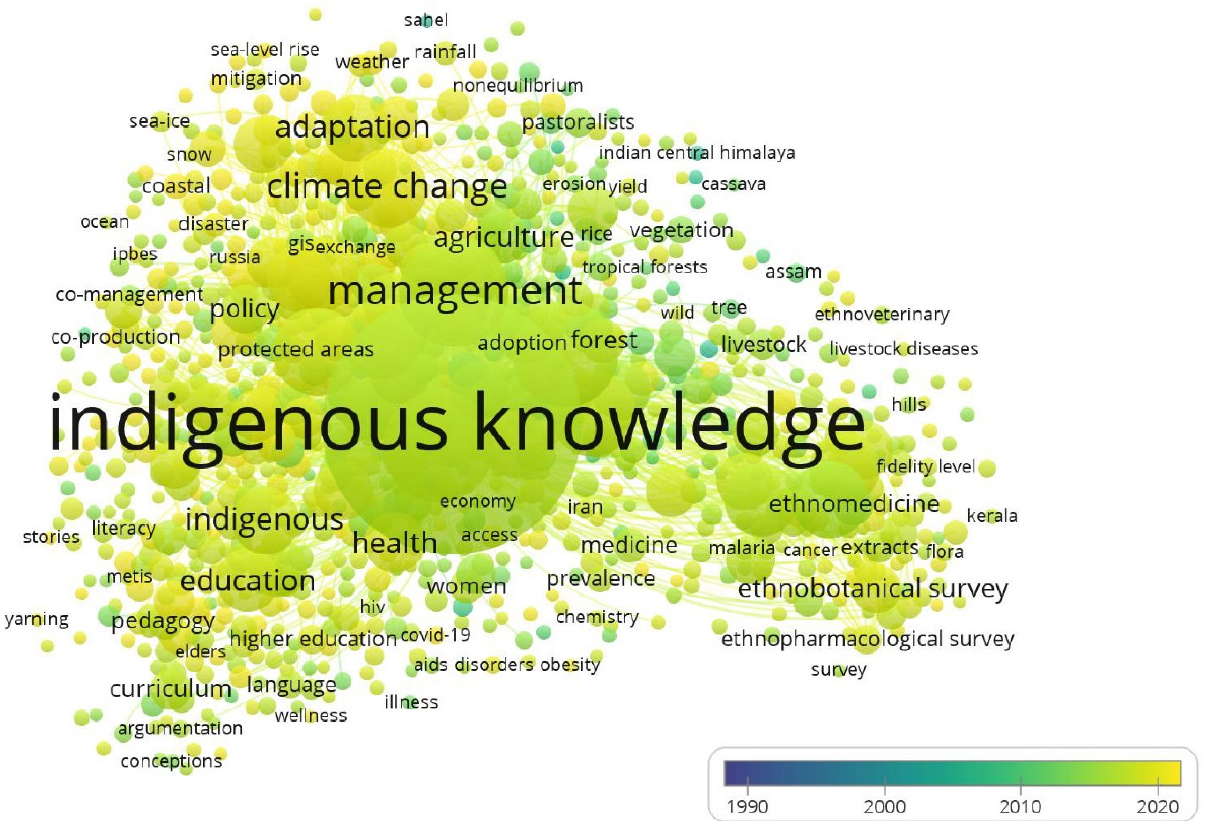
Figure 5. Overlay visualization of existing, current, and emerging trends by all keywords on indigenous knowledge. Map Source: VOSviewer.